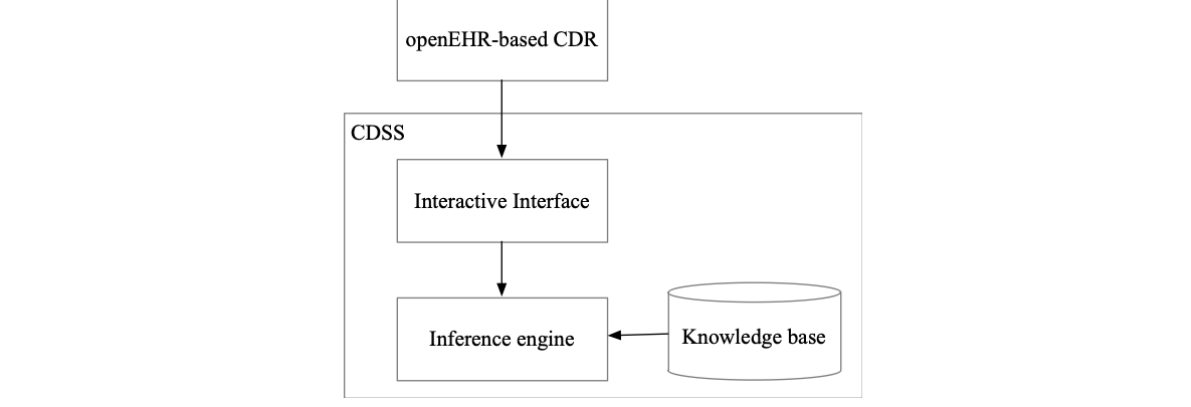
Figure 2. The interaction diagram between CDR and decision support tool. CDR: clinical data repository; CDSS: clinical decision support